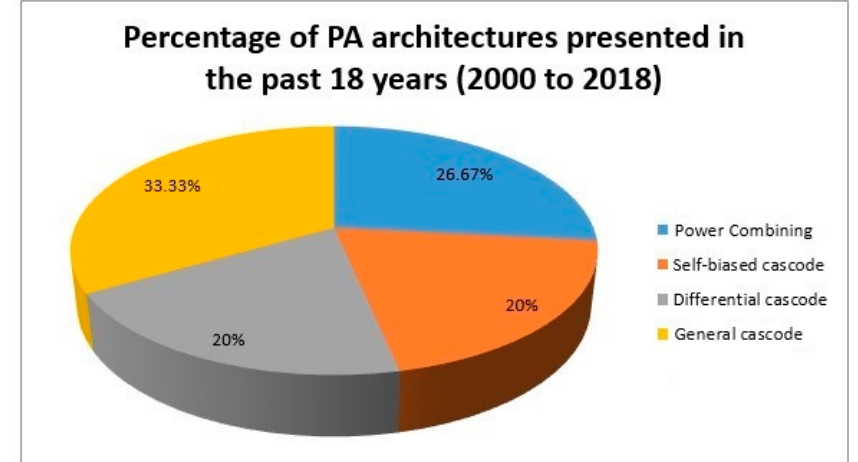
Figure 17. Pie chart of PA architectures in the past 18 years (2000 to 2018).